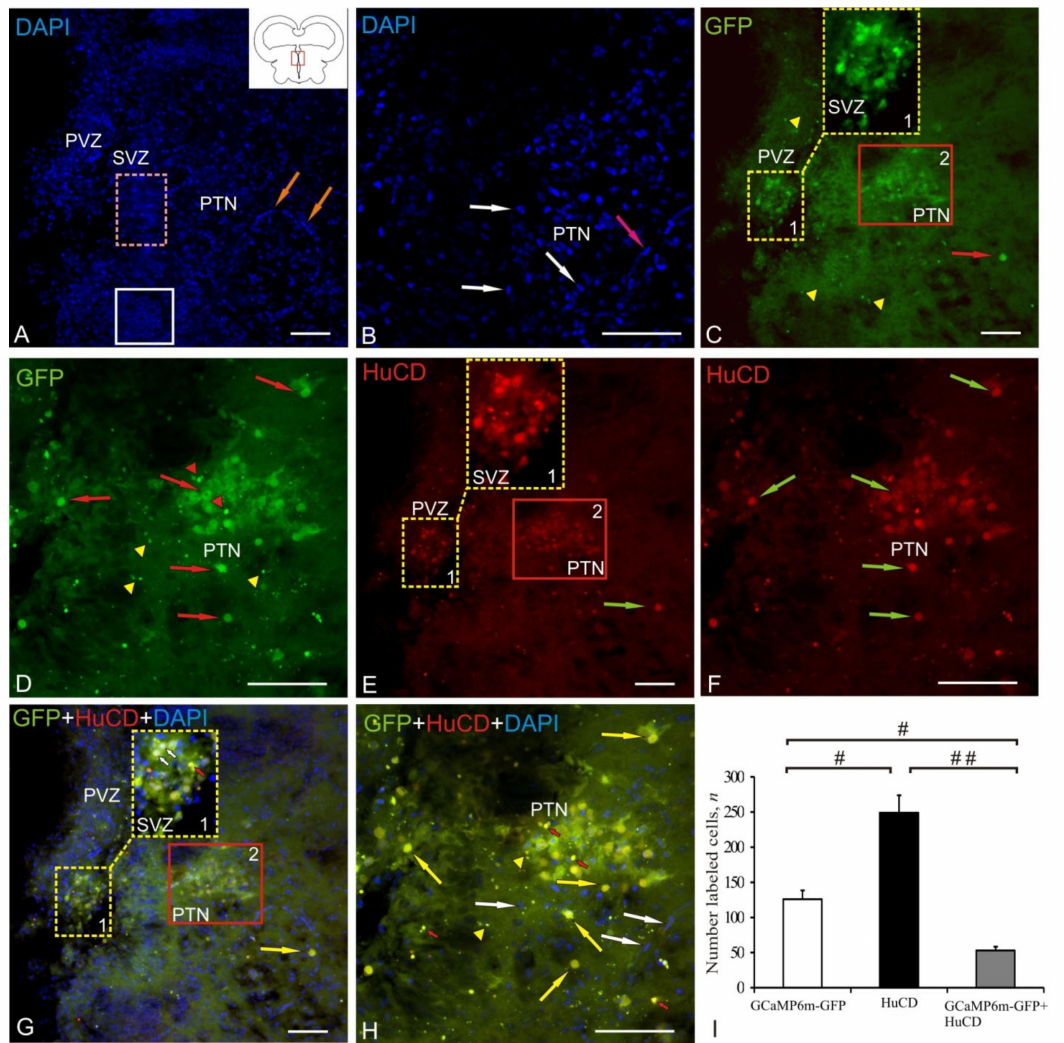
Figure 2. Z-stacks representing HuCD immunolabeling in the posterior tuberculum area of juvenile chum salmon, O. keta , at 1 week after a single injection of recombinant AAV into the mesencephalic tegmentum area. ( A ) DAPI staining, the pictogram shows the posterior tuberal area, morphologically heterogeneous nuclei forming dense clusters (in a white square), as well as multilayer clusters (outlined by pink dotted rectangle), abundantly vascularized (orange arrows), PVZ—periventricular zone, SVZ—subventricular zone, PTN—posterior tuberal nucleus. ( B ) PTN at higher magnification, heterogeneous nuclei with numerous nucleoli (white arrows), elongated nuclei of migrating cells (pink arrow). ( C ) Expression of green fluorescent protein GFP in PTA cells (red arrows), aggregation of GFP+ cells in SVZ (population № 1, yellow dashed rectangle) of heterogeneous composition (inset at high magnification), GFP+ neurons and nuclei in PTN (population № 2 in red rectangle), GFP+ granules (yellow arrowheads). ( D ) PTN at higher magnification, GFP+ nuclei (red triangular arrows). ( E ) Immunofluorescence of HuCD protein in PTA neurons (green arrows), population № 1 is shown with inset at higher magnification. ( F ) PTN at higher magnification. ( G ) Superposition of three DAPI/GFP/HuCD staining channels in PTA (populations № 1 and 2), demonstrating colocalization of GFP/HuCD in neurons (white arrows in the inset, population № 1) and nuclei (red arrow in the inset, population № 1) or PTN neurons (yellow arrow). ( H ) PTN at higher magnification, DAPI stained nuclei (white arrows), GFP+ granules (yellow arrowheads). Laser scanning confocal microscopy. Scale bars: ( A , C , E , G )—200 µ m; ( B , D , F , H )—50 µ ms. ( I ) ANOVA analysis results showing the comparative distribution of labeled cells and nuclei (M ± SD, where M is the mean and SD is the standard deviation) of the posterior tuberal area of the chum salmon. Significant intergroup differences were found between the groups of GCaMP6m-GFP+ and HuCD+, between GCaMP6m- GFP+ and GCaMP6m-GFP+/HuCD+ (# < 0.05) cells; and between the groups of HuCD+ and GCaMP6m-GFP+/HuCD+ (## < 0.01) cells ( n = 5 in each